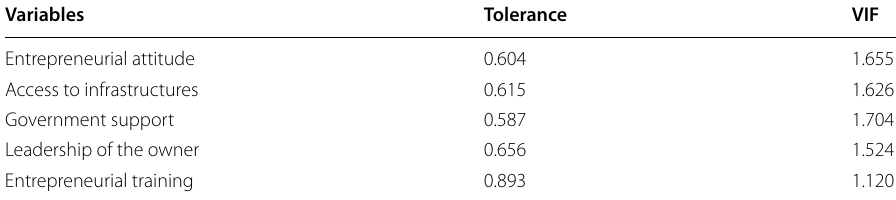
Source: Own Survey